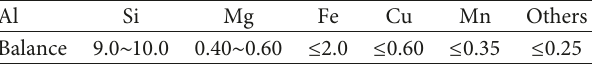
Figure 1: SEM image of the AlSi10Mg alloy. Table 1: Chemical composition of the AlSi10Mg alloy (wt.%).